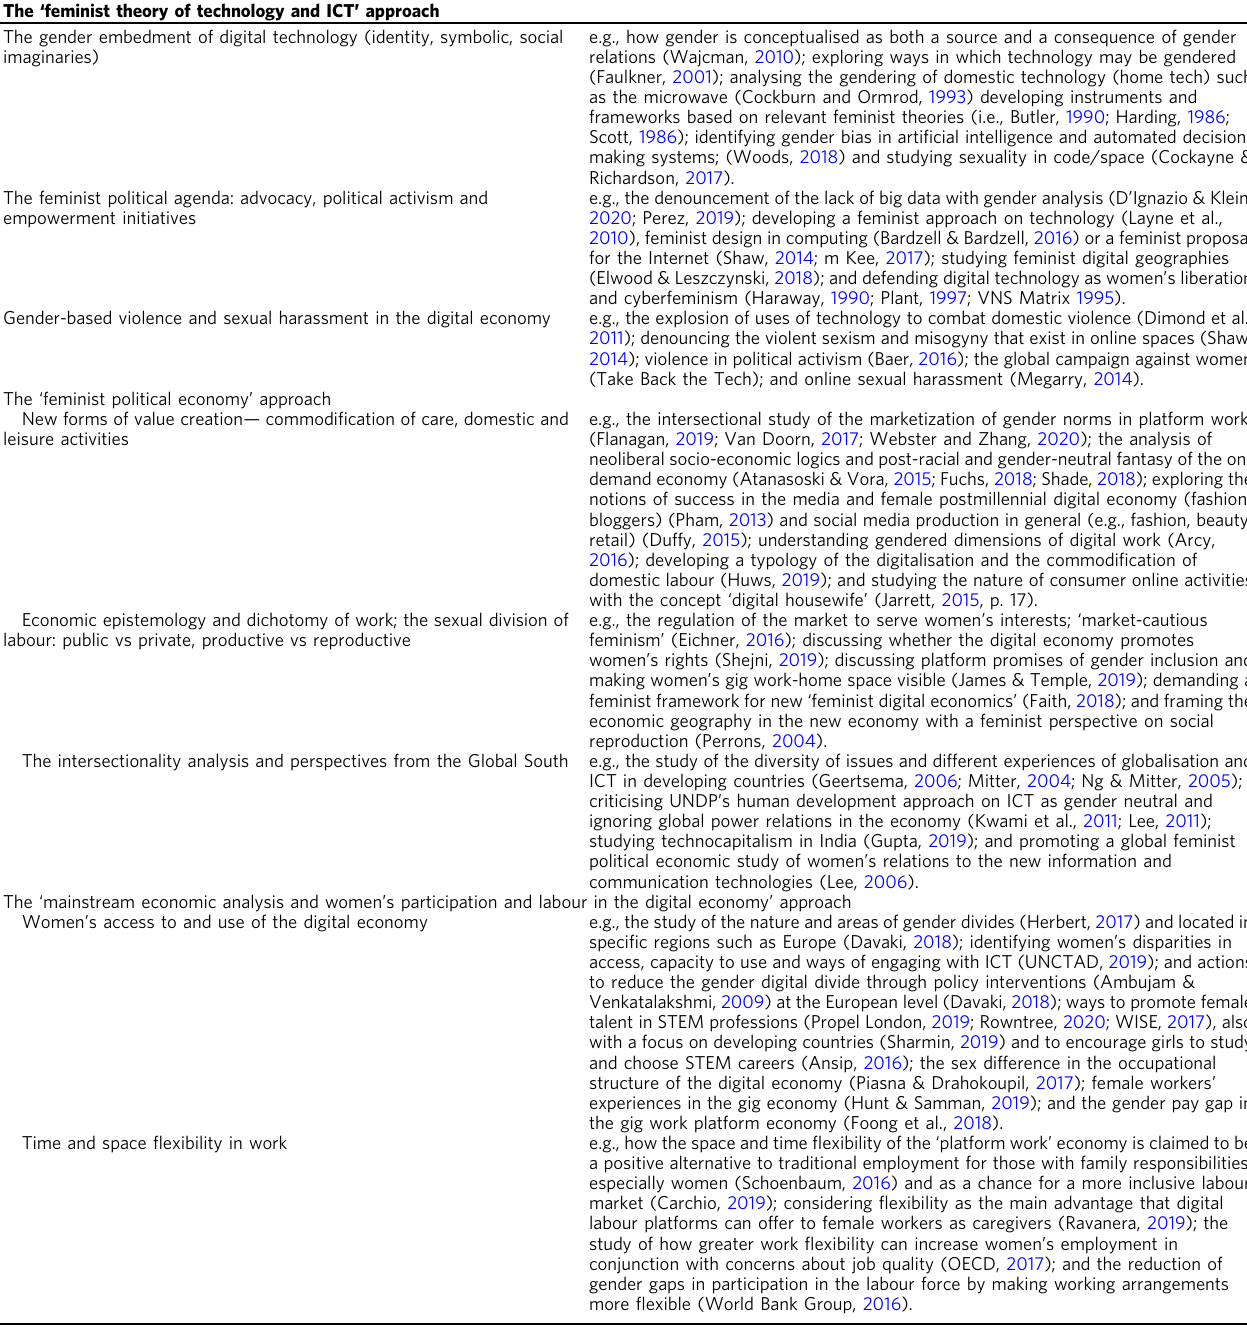
Table 5 Gender issues addressed in the